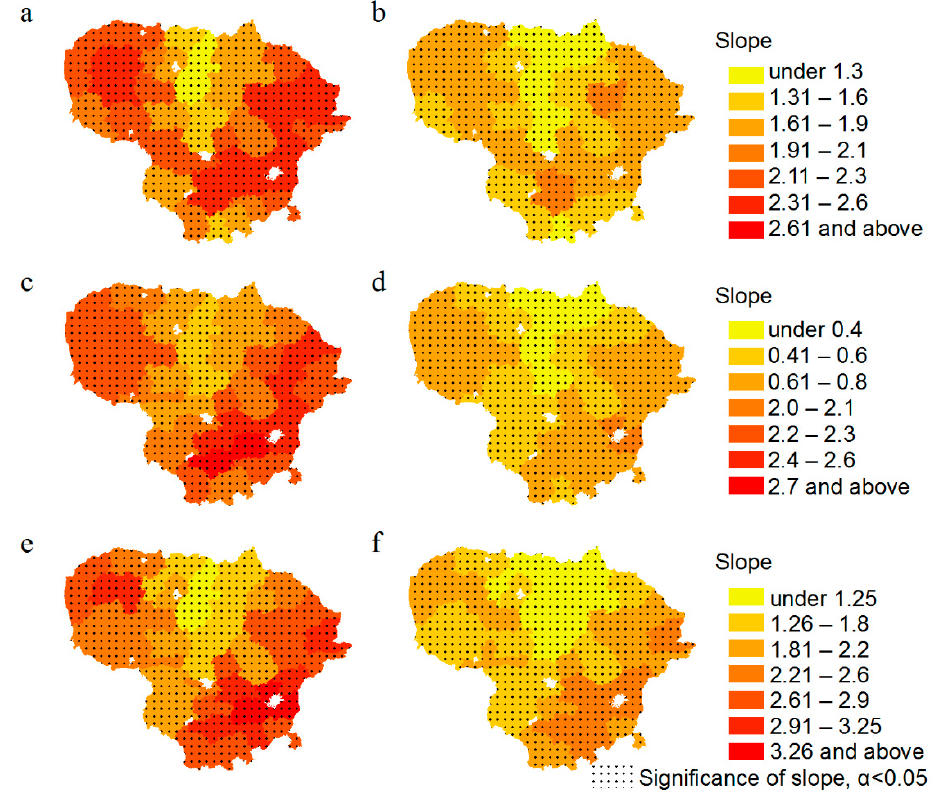
Figure 6. Pattern of climate change e ff ects on selected dendrometric attributes in Lithuanian forests during next 100 years from 2020 to 2120: ( a ) Standing volume in 1 ha, REFERENCE scenario, ( b ) standing volumein1ha, EUBIOENERGYscenario, ( c )averagediameterofallforeststands, REFERENCEscenario, ( d ) average diameter of all forest stands, EU BIOENERGY scenario, ( e ) annual wood volume increment, REFERENCE scenario, ( f ) annual wood volume increment, EU BIOENERGY